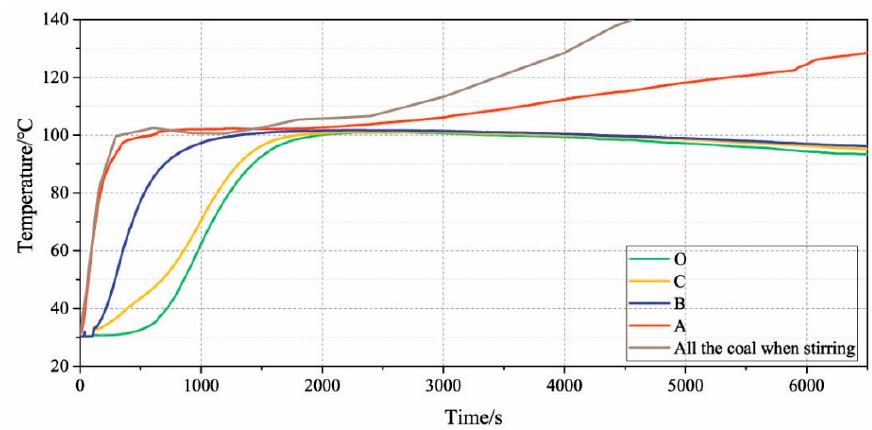
Figure 9. The temperature change of static and stirring drying.